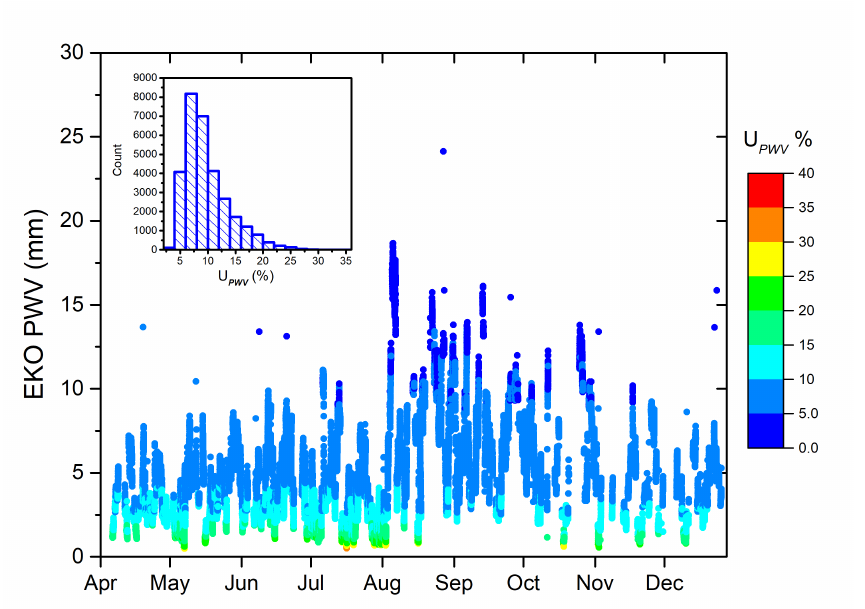
Figure 5. Time series of PWV determined from normal direct irradiance (DNI) measured with an EKO MS 711 between April and December 2019 at IZO. The color scale indicates the relative U PWV in %. The small figure represents the histograms of the relative U PWV in